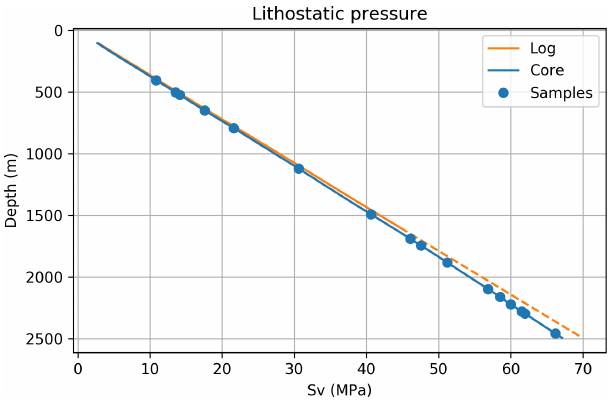
Figure 4. Lithostatic pressure curve of the COSC-1 borehole de- rived from core and downhole density measurements (Lorenz et al., 2015b). The values for the 16 core samples are marked accord- ingly. The dashed line was linearly extrapolated since downhole density was only logged down to about 1.6km.